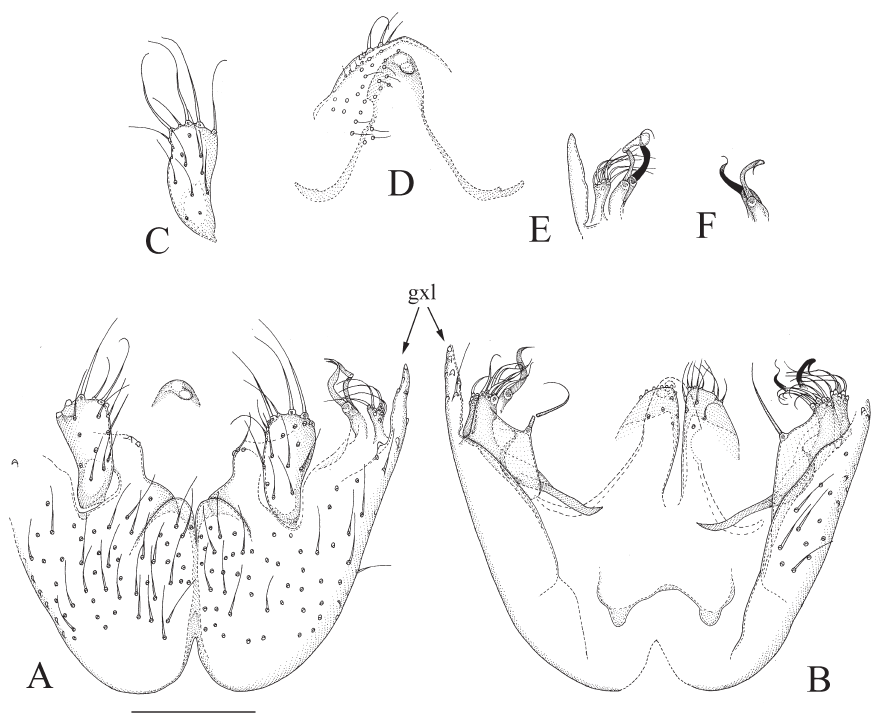
Figure 4. Manota setilobata sp. n. ( A, B, D, E and F holotype, C paratype). A Hypopygium, ventral view B Hypopygium, dorsal view C Right gonostylus, ventral view D Aedeagus and hypoproct, ventral view E Left side juxtagonostylar megasetae with associated parts, dorsal view F Right side juxtagonostylar megasetae. Scale bar 0.10 mm. Abbreviation: gxl = posterolateral lobe of gonocoxa. gonocoxa with a large plate-like lobe bearing one strong seta at posteromedial corner; gonostylus elongated subquadrangular, slightly sunken into gonocoxa; two juxtago- nostylar megasetae, both twisted, the more dorsal one apically flattened and dilated; posteriorly from the juxtagonostylar megasetae a narrow flat apically setose lobe. Description. Male. Colour. Head brown, face somewhat paler. Antenna light brown, including scape and pedicel. Clypeus and mouthparts yellowish. Thorax light brown. Legs yellowish. Wing with light brownish tinge because of microtrichia; haltere yellow with blackish knob. Abdomen with tergites dark brown to blackish, sternites light brown to yellowish. All vestiture pale, yellowish or brownish, thicker setae and trichia seeming darker than finer ones. Head. Antennal flagellomere 4 ca. 2.3 times as long as wide. Palpomere 3 of maxillary palpus with apicomesial thumb-like exten- sion, with three apically curved sensilla; palpomere 4 with parasegment; palpomere 5 missing in both known specimens. Number of strong postocular setae, 10. Thorax. Anepisternum with 29–33 setae; anterior basalare, preepisternum 2 and laterotergite non-setose; metepisternum with 3–5 setae. Legs. Mid and hind tibial organs